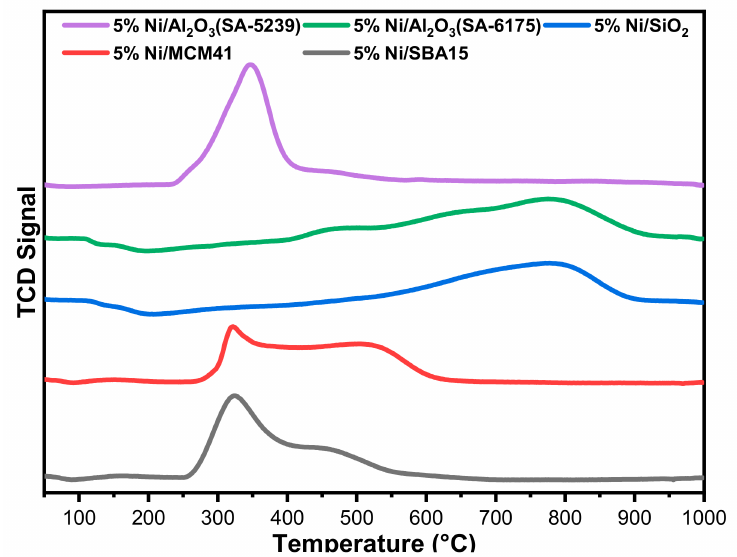
Figure 3. Temperature-Programmed Reduction (TPR) profiles for the Ni-supported